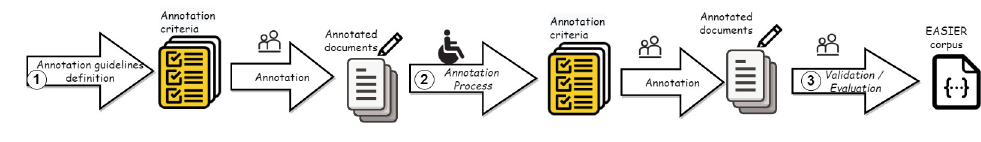
Fig 1. Corpus building